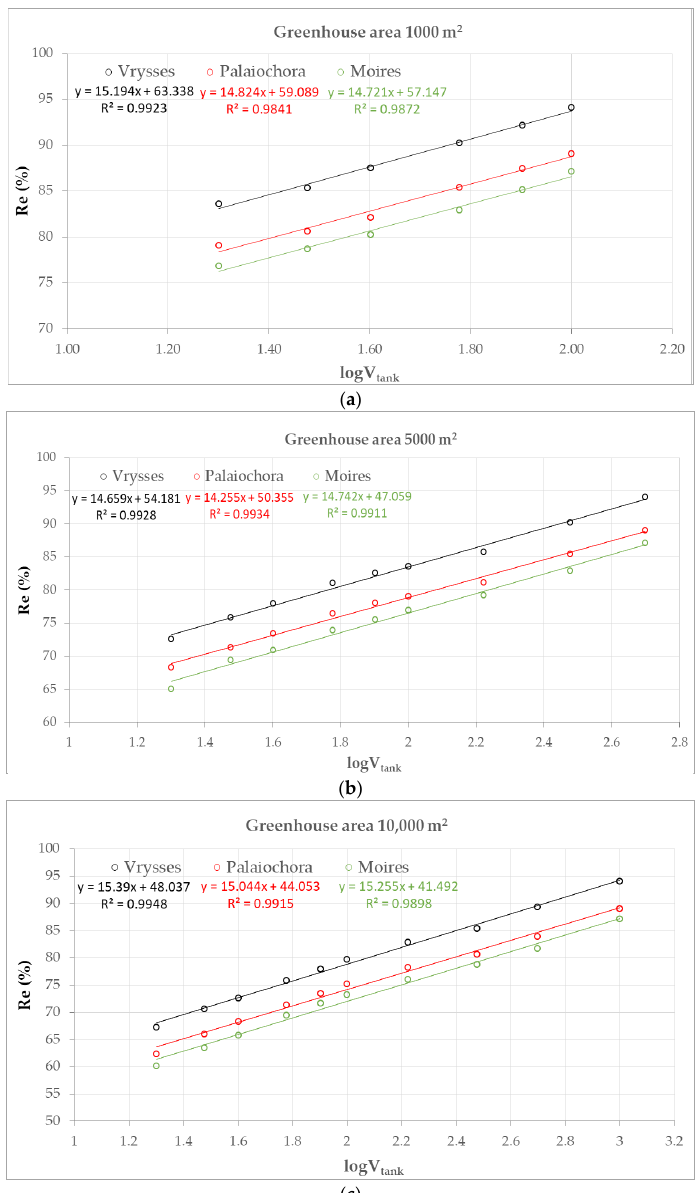
Figure 8. Comparative presentation of the relationships between reliability coefficients and log values of uncovered rainwater tank volumes, Re (log V tank ), for meeting the tomato crop water needs for ( a ) 1000 m 2 , ( b ) 5000 m 2 and ( c ) 10,000 m 2 greenhouses in three study areas (Vrysses, Palaiochora and Moires). The volumes of V tank are in m 3